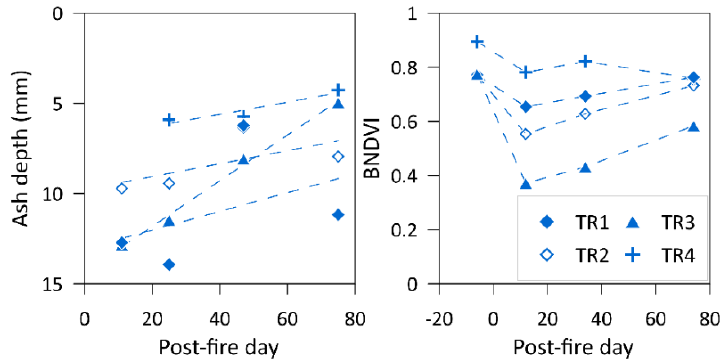
Figure 10. Comparing the Redford Canyon Fire field data and BNDVI values from Sentinel-2 spectral data. Ash depth (left) and BNDVI (right) are plotted over time by transect. The y-axis on the left panel is inverted to ease the comparison between ash depth and BNDVI.